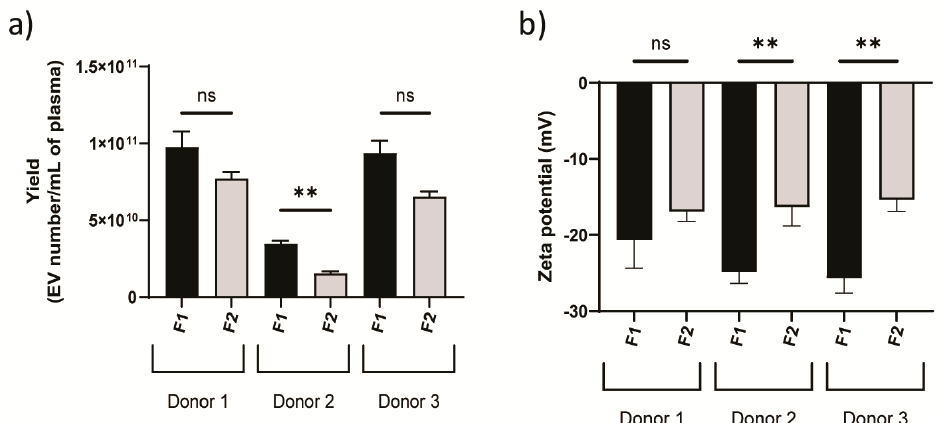
Figure 3. Yield and zeta potential of plasma-derived EVs. ( a ) Yield for each sample normalized to 1 mL of original plasma determined by NTA. ( b ) Zeta potential was obtained through laser Doppler micro-electrophoresis. Statistics by Student’s t -test. ** p < 0.0075; ns, not significant.